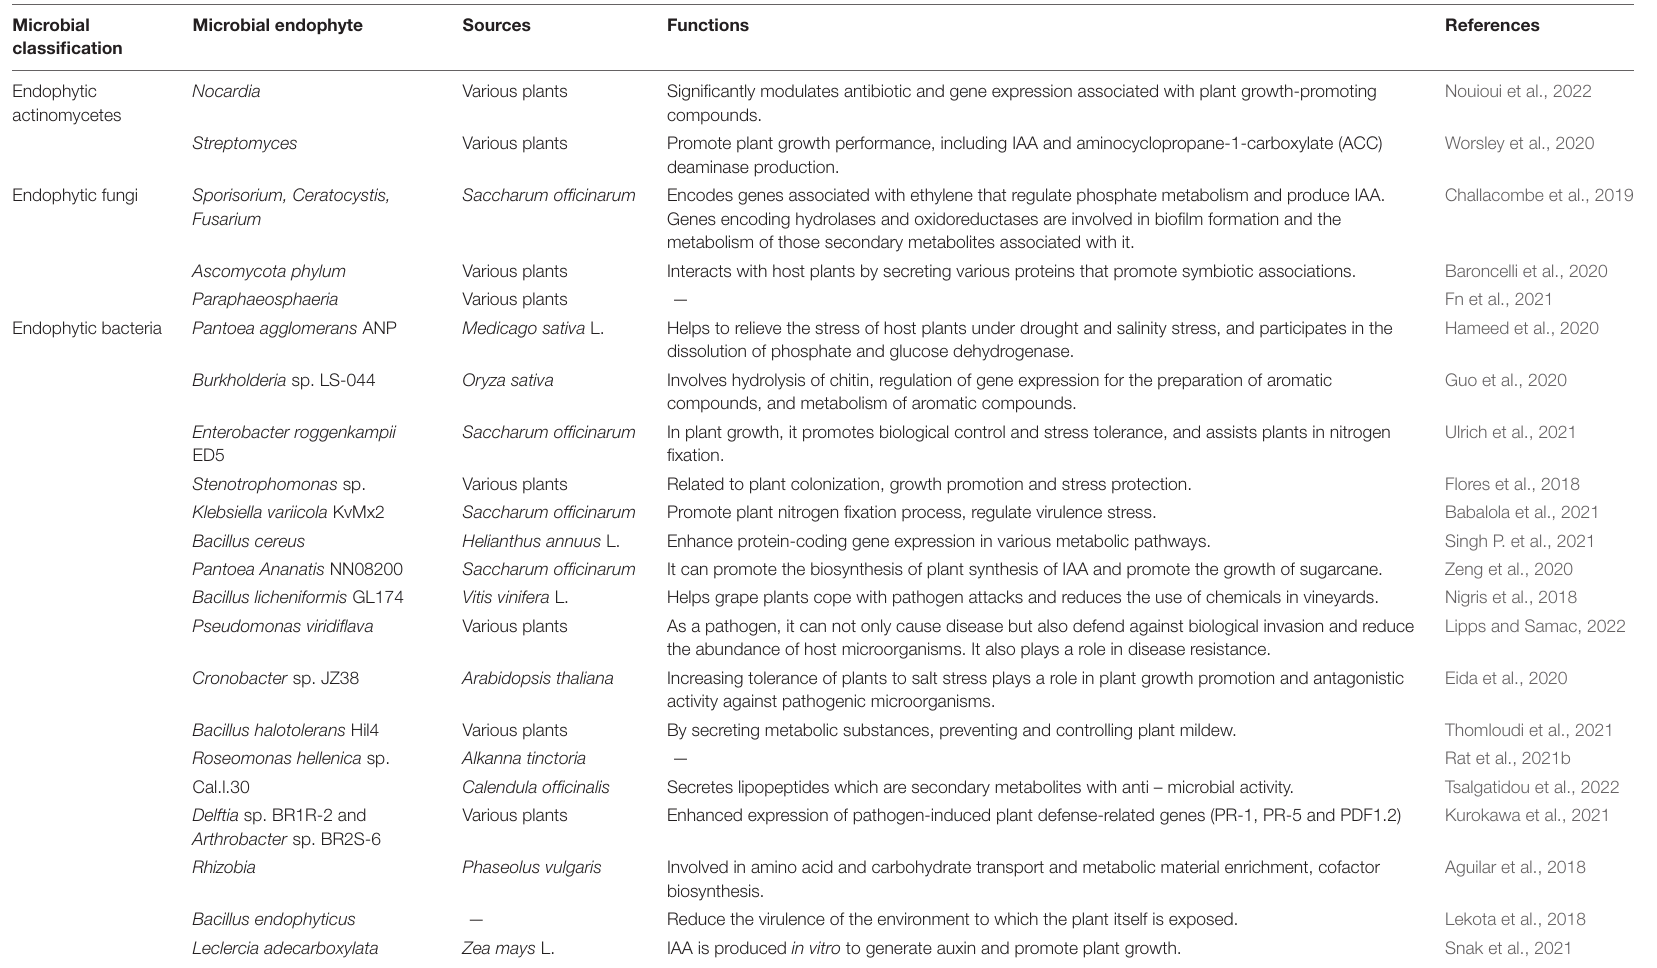
TABLE 1 | List of selected endophytes genome sequenced in last 5 years (2018–2022). Microbial